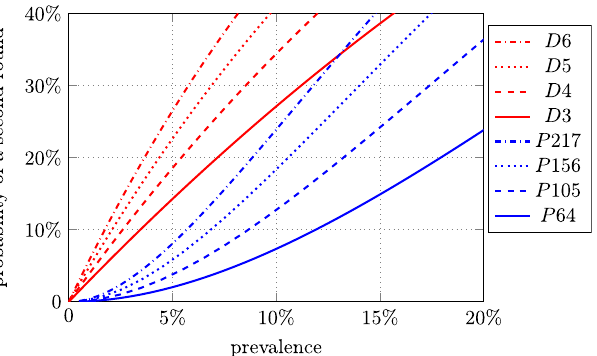
Figure 2. Probability of a second testing round for an individual, as a function of the prevalence. Dn = Dorfman with n individuals and one pool; Pnp = protocol P with n individuals and p